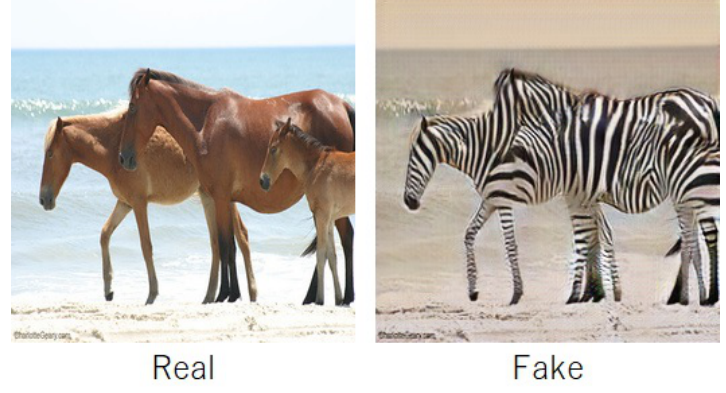
Figure 2. An example of a fake image in the CycleGAN